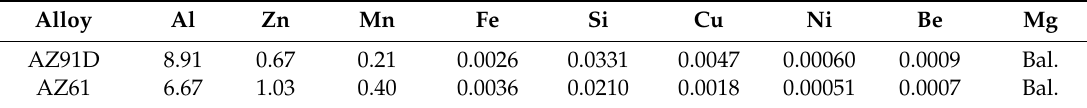
Table 1. Thechemical composition of AZ91D and AZ61 alloys